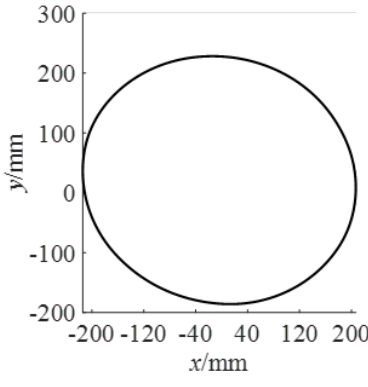
Figure 15. Motion characteristics after optimization.